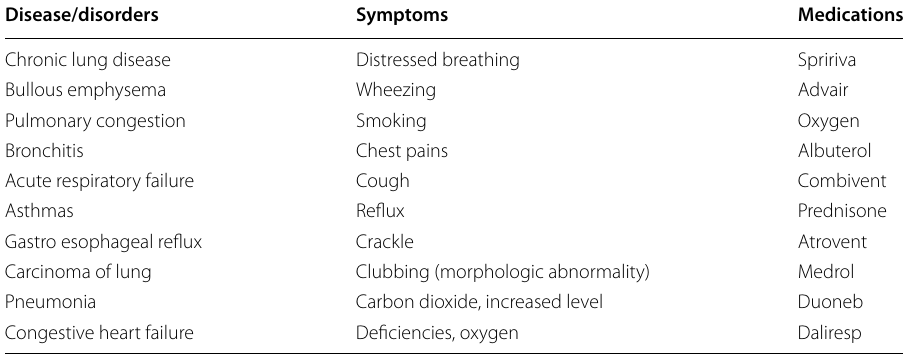
Table 2 Selection of ground-truth terms Disease/disorders